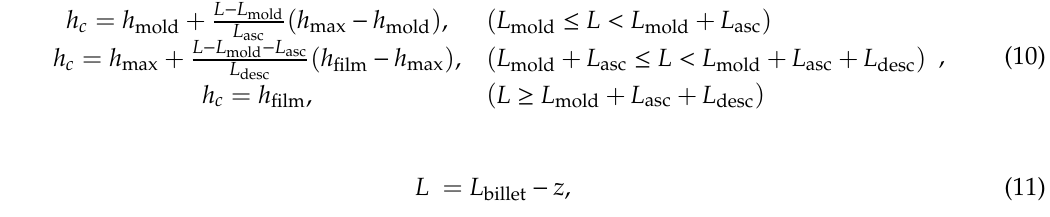
Table 2. Case 1 and case 2 correspond to the grain-refined and non-grain-refined billets, respectively. The nucleation law used for the grain-refined billet (case 1) is evaluated based on the measured size distribution of an Al-Ti-B grain refiner [28], while that used for the non-grain-refined billet (case 2) is adjusted based on the experimental observation reported by Vreeman et al. [21]. Cases 3–6 are designed to study the e ff ects of the casting speed and casting temperature on the non-grain-refined billet. For each case, fully coupled and transient simulation is performed, and the grain structure and macrosegregation in the entire billet are